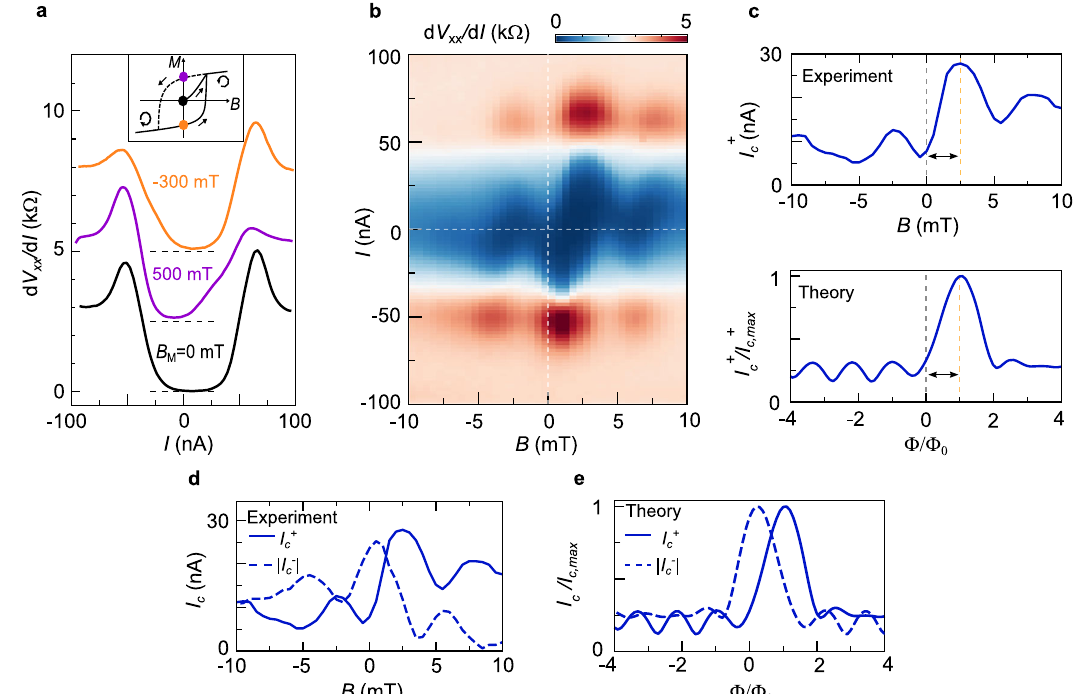
Fig. 3 | JJ with orbital magnetism. a dV xx / dI vs. I measured at B =0mT and T =800mKrightaftercooldown(black)andafterthesamplehasbeensubjectedto two opposingpre-magnetizing fi elds B M .The curvesare vertically shifted by2.5k Ω eachforclarity.The insetshows aschematicof magnetization M vs. B .The colored dots correspond to the magnetic states in which the different dV xx / dI vs. I curves were taken and the arrows describe the direction in which the fi eld is swept. b Fraunhofer pattern with n J = − 1.56×10 12 cm − 2 measured at 800mK. The white dashed lines mark the 0 current and 0 fi eld positions. c (Top) Positive critical current I c + vs. B at 800mK. The vertical dashed lines remark the shift of the I c +